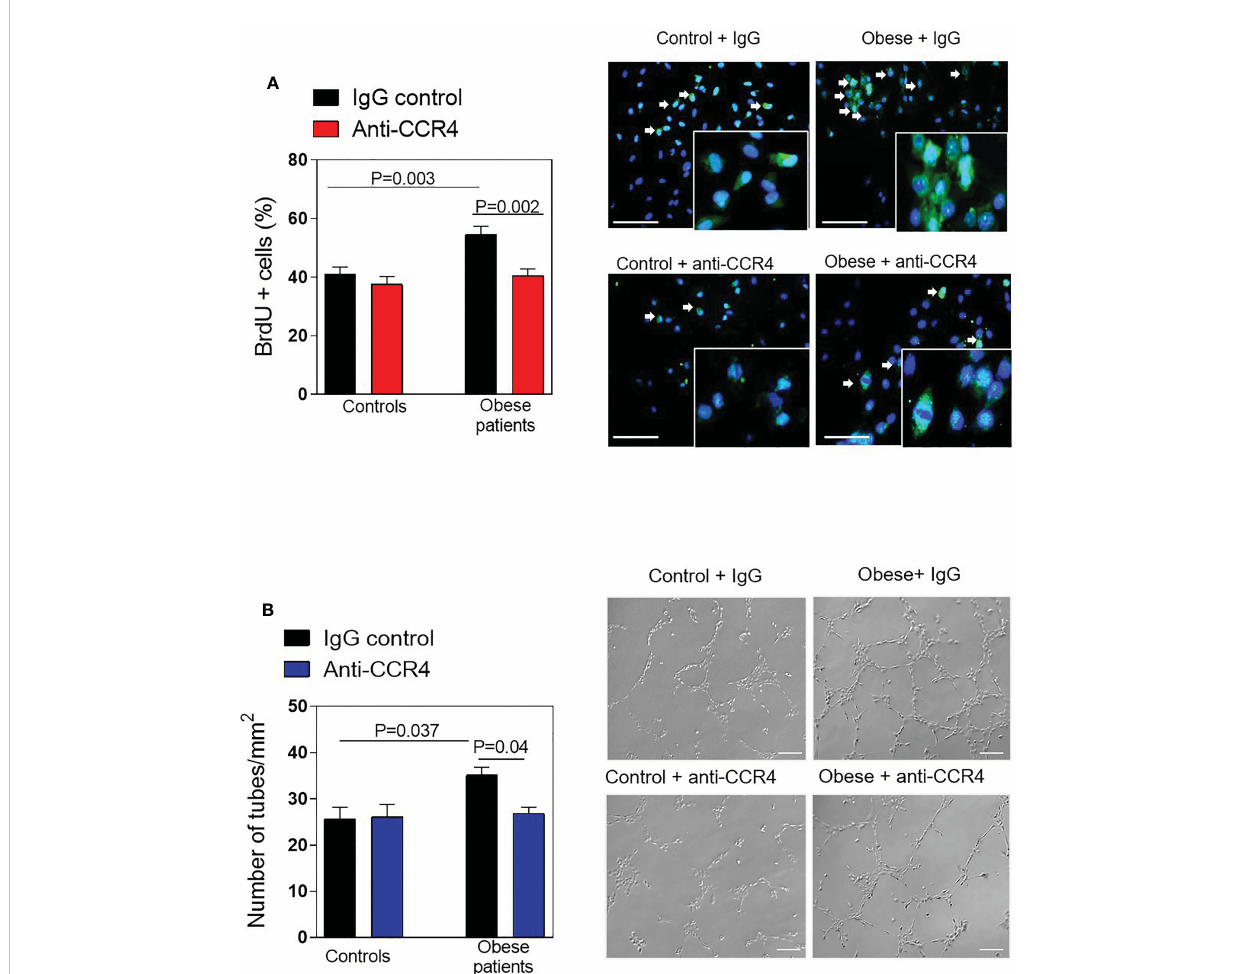
FIGURE 5 Neutralizing CCR4 reduces endothelial cell proliferation and morphogenesis. (A) HAEC were incubated with plasma (diluted 1:10 in HBSS) from morbid obese patients or controls subjects for 24h. Some plates were preincubated with a monoclonal blocking antibody against human CCR4 (3 µg/mL). Percentage of proliferating endothelial cells was analysed by BrdU incorporation. Data represent the mean ± SEM of the percentage of BrdU + cells in 3 random fi elds (40x). (n = 8 control subjects and n = 8 morbidly obese patients). Right panels show representative images of endothelial cell proliferation. Scale bar, 100 m m. (B) Cells cultured in Matrigel were incubated with plasma (diluted 1:10 in HBSS) from obese patients or controls. Phase contrast images were taken after 4 h of incubation and the number of tube-like structures were quanti fi ed. Data represent mean ± SEM of the number of tube-like structures or total length of the tubes in 4 random fi elds (10x). (n = 10 control subjects and n = 10 morbidly obese patients). Right panels show representative images of endothelial cell differentiation on Matrigel. Scale bar, 200 m